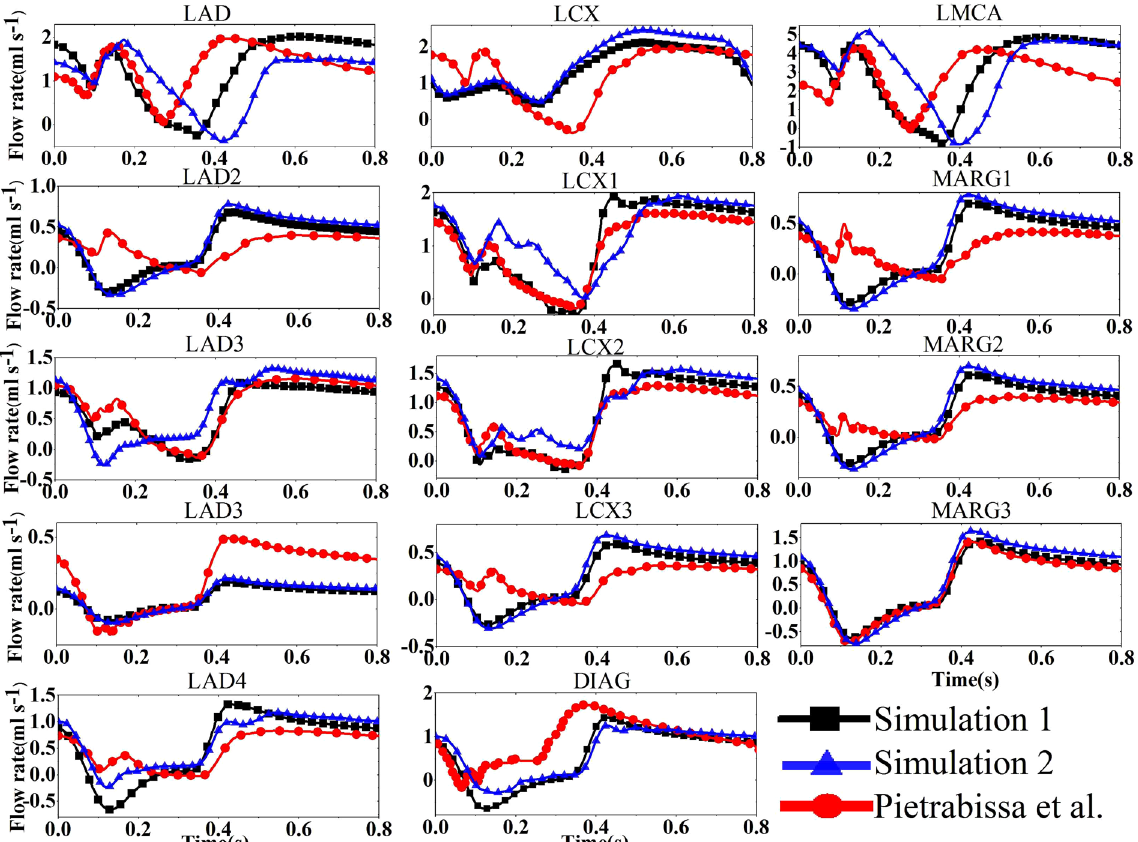
Figure 1. Simulated flow rates over one heart beat along different sections of the left coronary arteries, based on our geometry (Simulation 1), on the geometry by Pietrabissa et al . 7 (Simulation 2), and the model result by Pietrabissa et al . based on a constant resistance.